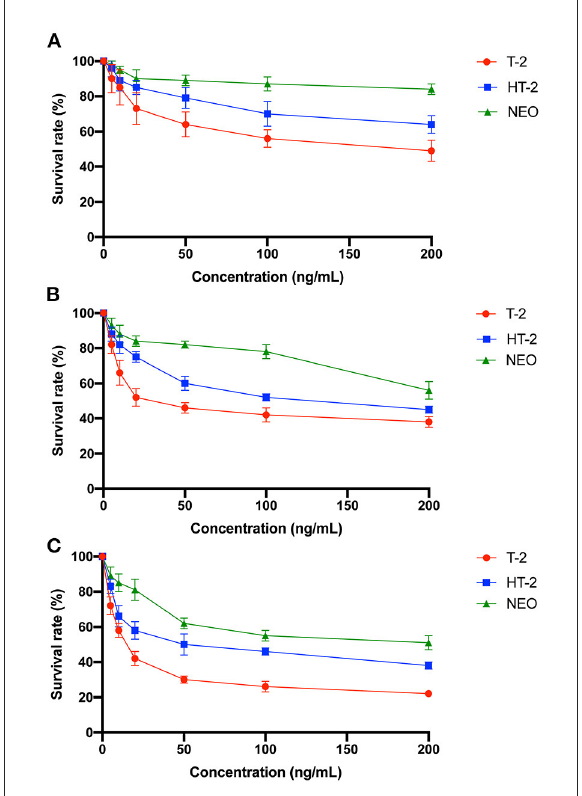
FIGURE4 Decreased cell viability of the chondrocytes after treated with T-2 toxin and its hydrolytic metabolites. C28/I2 cells were treated with 0–200ng/mL of T-2 toxin, HT-2 toxin, and NEO for 12 (A) , 24 (B) , and 48 (C) h. Data are presented as mean ± SD ( n = 3 each). NEO,